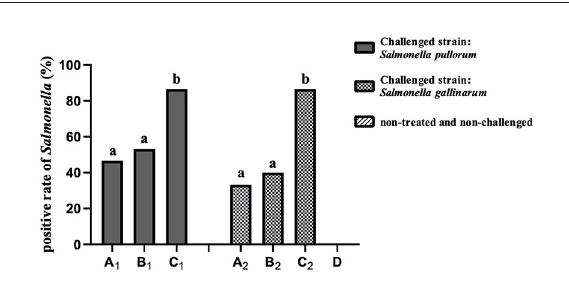
FIGURE3 The total positive rates of Salmonella in the SP and SG challenge-protection experiments.